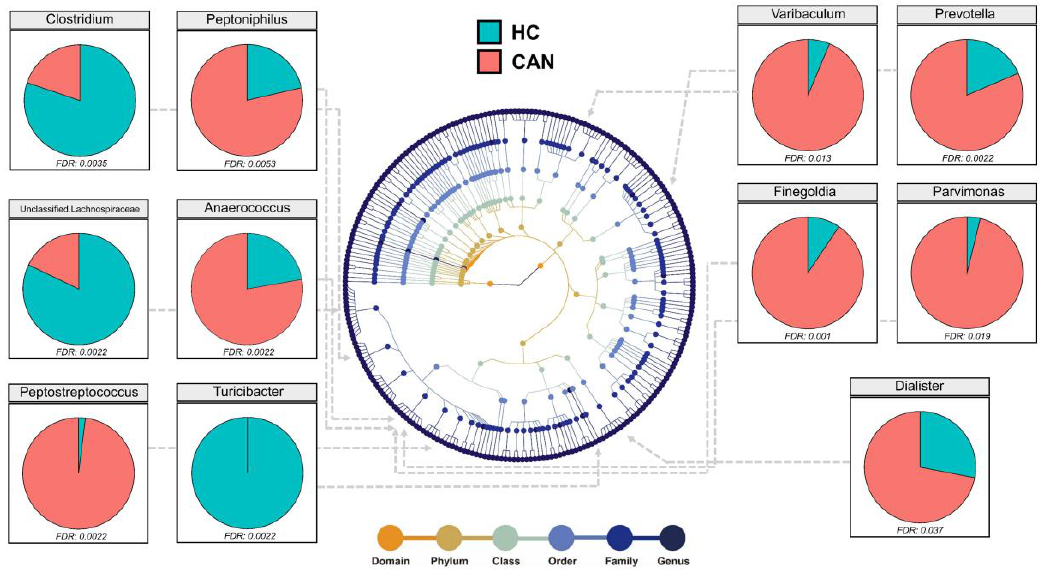
Figure 3. Differential abundance analysis of fecal microbiota at the genus level. Only statistically significant genera were displayed (Wilcoxon rank sum test, False discovery rate (FDR) < 0.05). Different colored points in the phylogeny represent taxonomic levels.